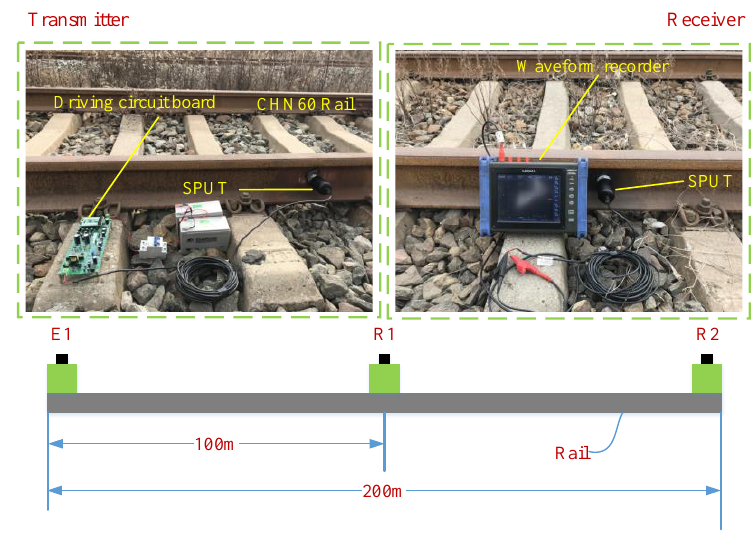
Figure 6. Field test diagram of encoding excitation.